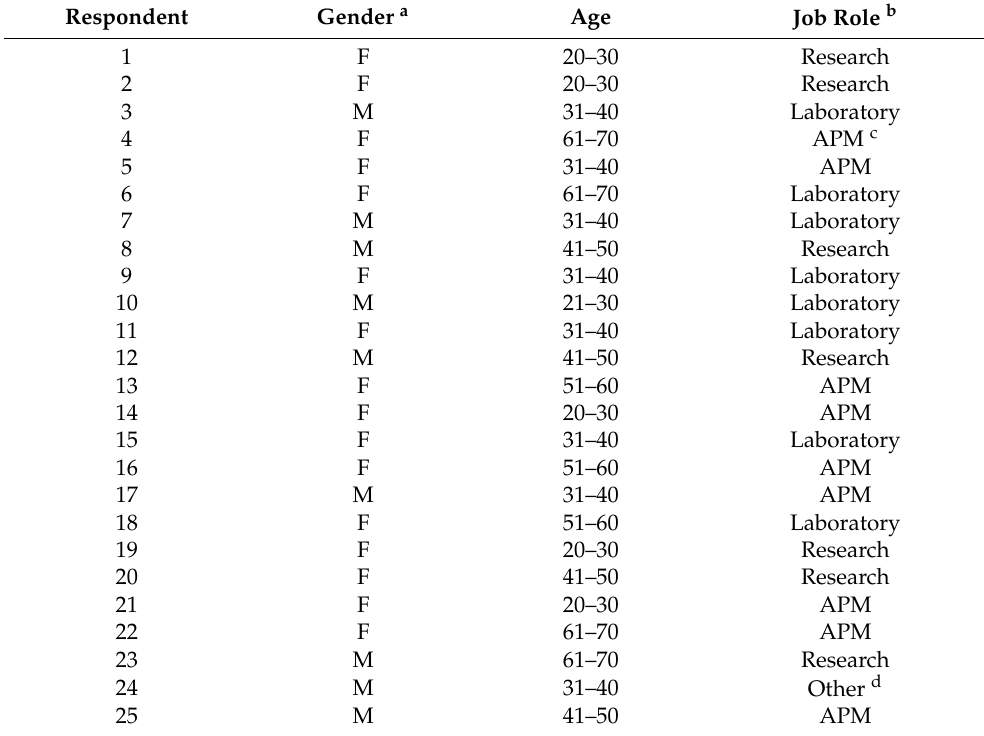
Table 1. Participant